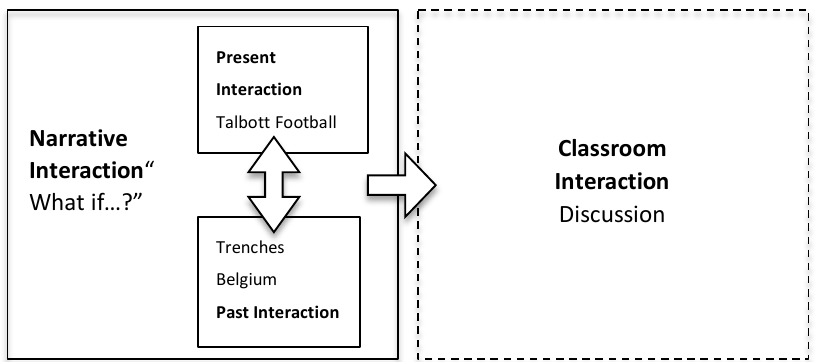
Figure 3 . Relationship between narrative frame and classroom interactional frame in Invasion of Talbott/Belgium and Football/Trench Warfare